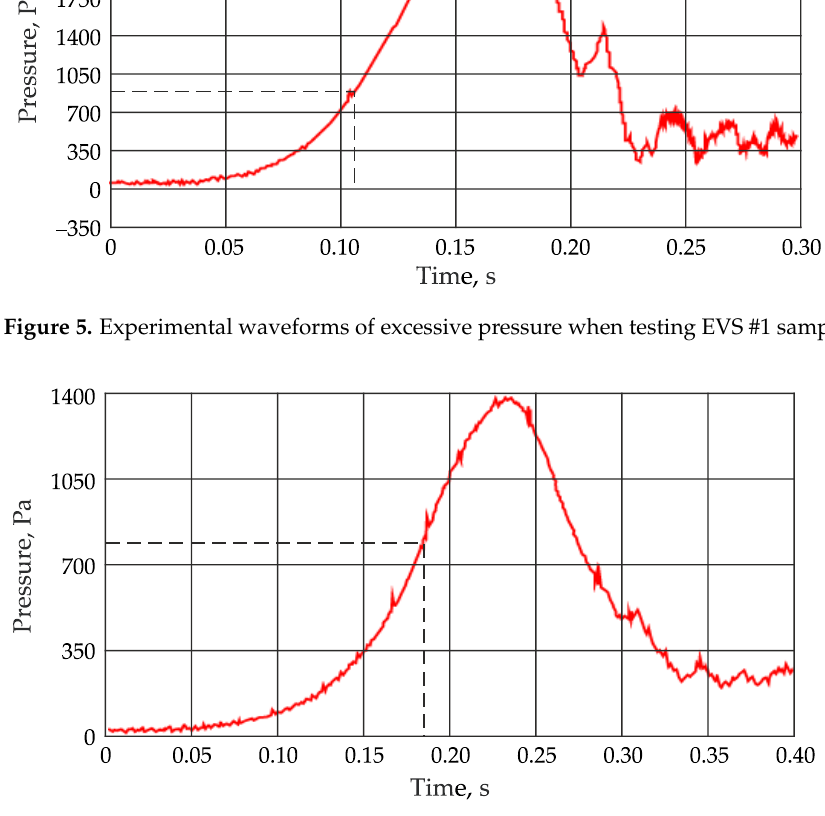
Figure 6. Experimental waveforms of excessive pressure when testing EVS #2 sample.